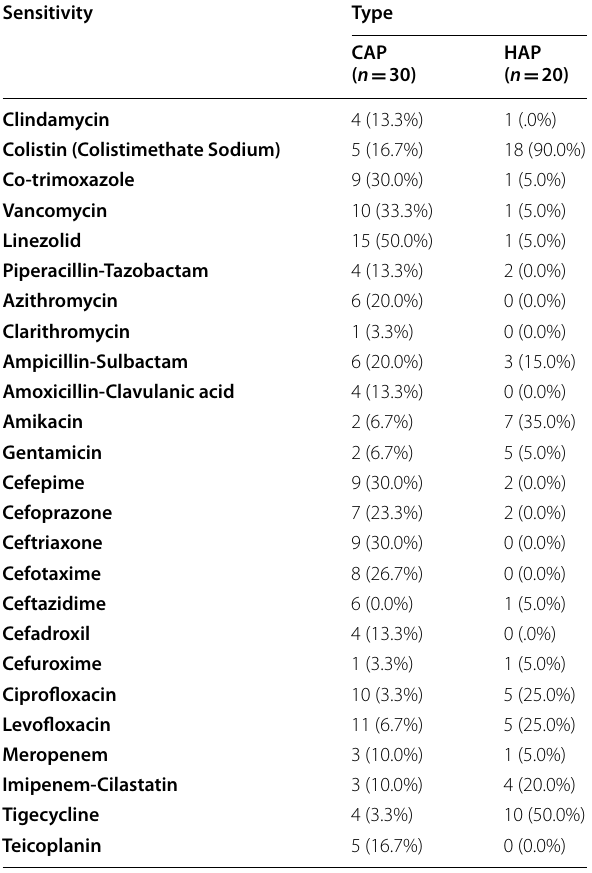
Table 4 Antimicrobial sensitivity pattern among the studied pneumonia